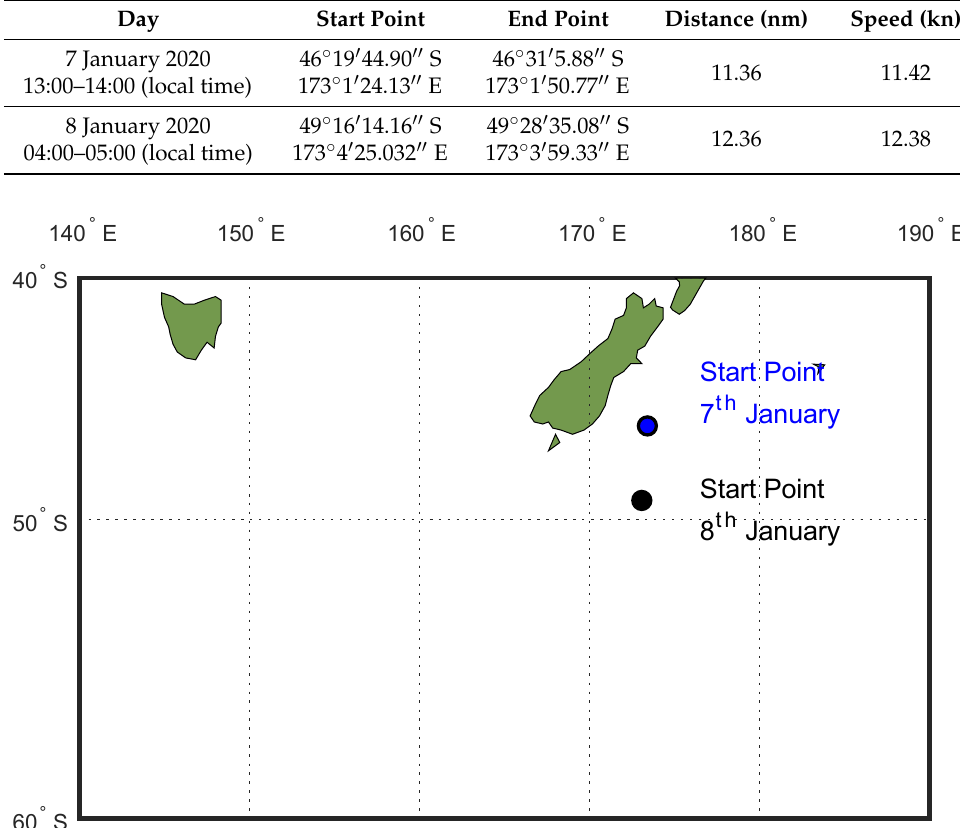
Figure 2. Ship’s starting position during the data collection events.